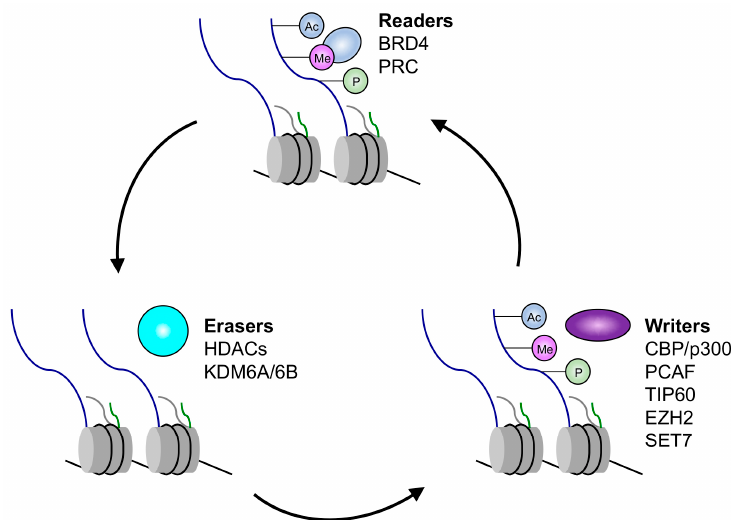
Figure 1. Summary of histone readers, writers, and erasers targeted by human papillomavirus (HPV). Abbreviations: BRD4: bromodomain-containing protein 4; PRC: polycomb repressive complex;